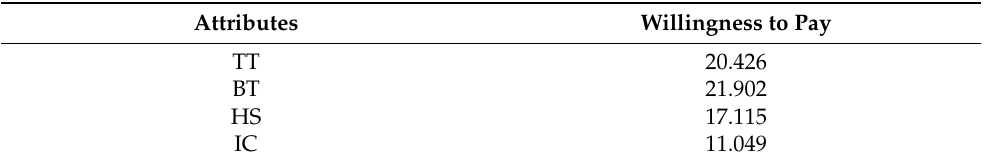
Table 6. Consumers’ willingness to pay for traceability technology applications and guarantee attributes